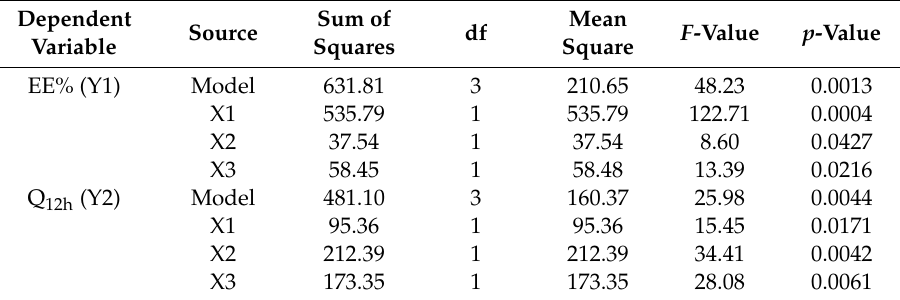
Table 3. ANOVA for the 2 3 factorial design of SV-loaded